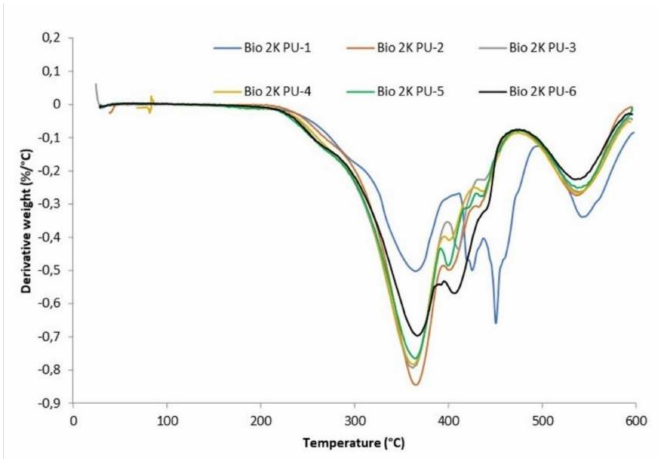
Figure 8. DTG curves of the bio-based 2K PU coatings in air.